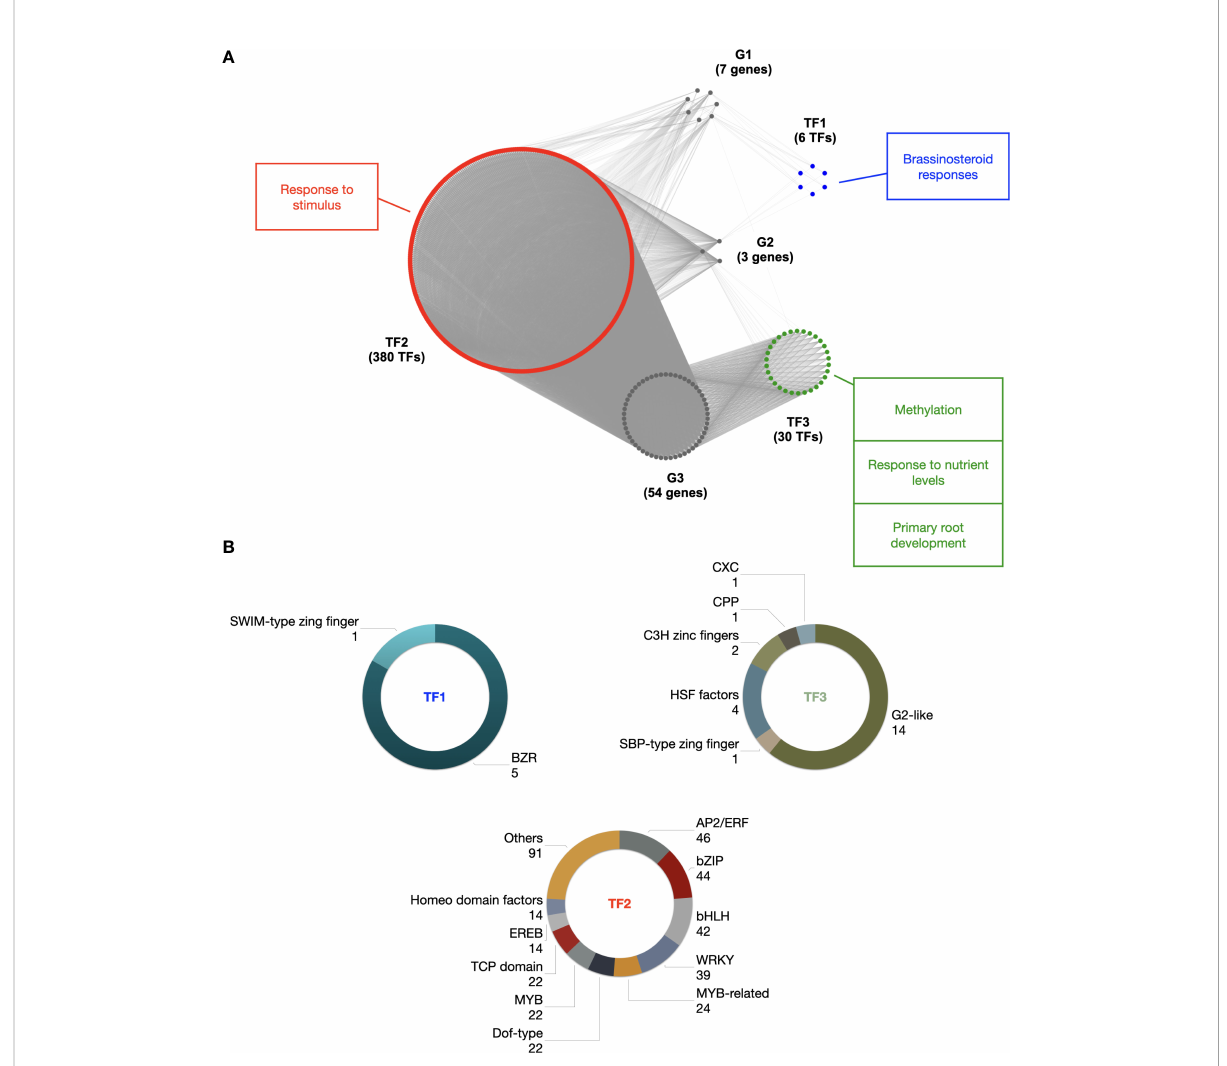
FIGURE 7 Gene regulatory network of the HOM04M002476 gene family of Z. mays. (A) Topological structure of the gene regulatory network of the HOM04M002476 gene family. G1, G2 and G3 are the three HOM04M002476 gene modules (grey) identi fi ed by the LBM procedure. TF1 (red), TF2 (green) and TF3 (blue) are the three TF modules identi fi ed by the LBM procedure potentially involved in the regulation of HOM04M002476 genes. GO enrichments of TF modules are indicated with corresponding colors. (B) TF families associated to the three TF